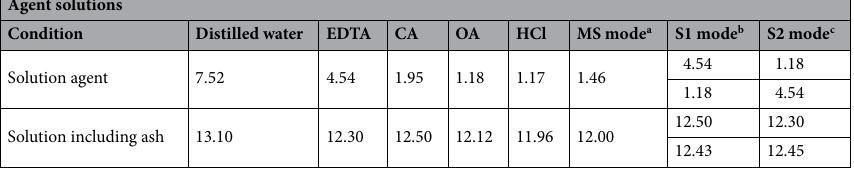
Table 4. The measured pH values of the various solutions. a Removal using EDTA and OA simultaneously. b First step: EDTA; second step: OA. c First step: OA; second step: EDTA.